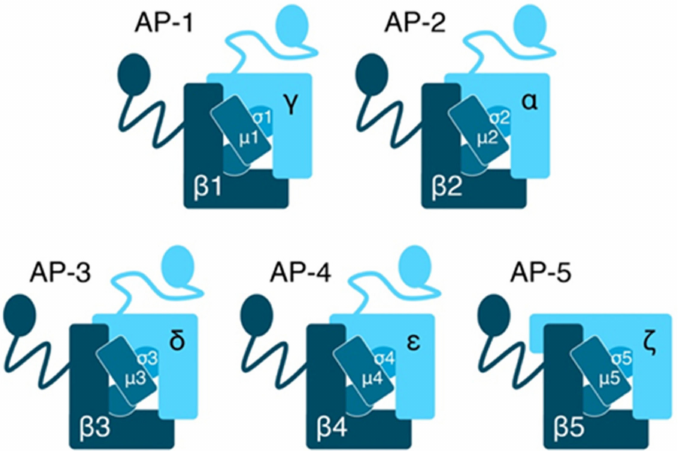
Figure 1. Family of AP-complexes and their subunit composition. Each complex is composed of two large adaptins, one medium-sized µ -adaptin and one small σ